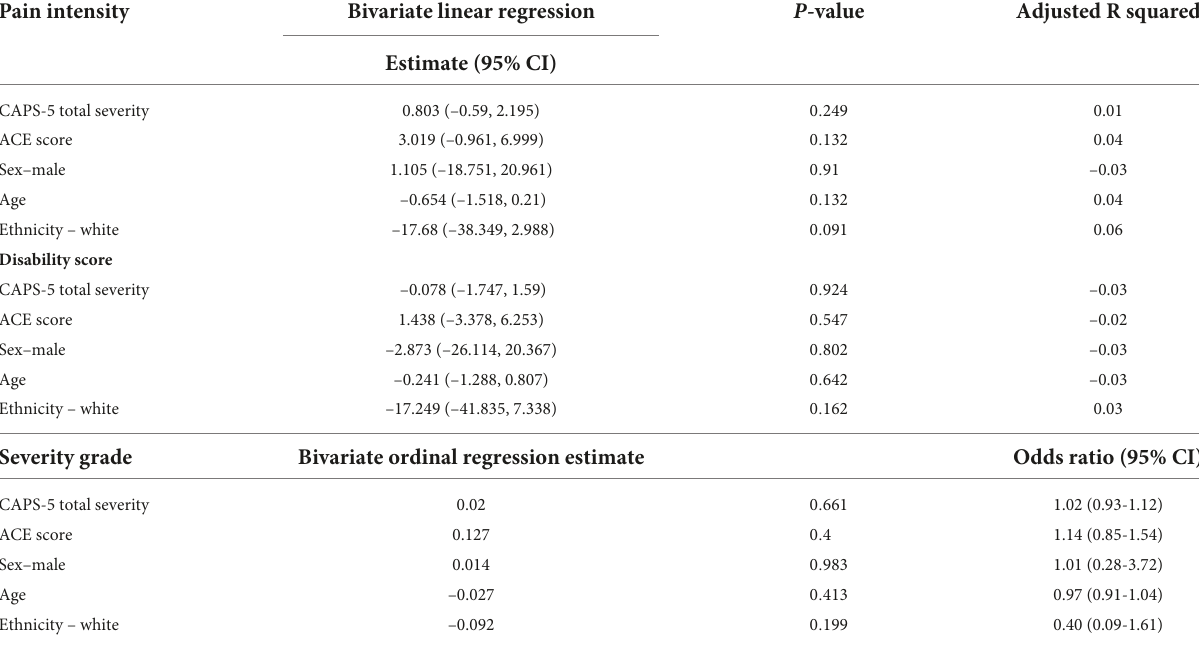
TABLE 3 Bivariate linear and ordinal regression reveal no strong associations between pre-treatment CPG subscale values and pre-treatment CAPS-5 total severity, ACE score, or demographic variables.